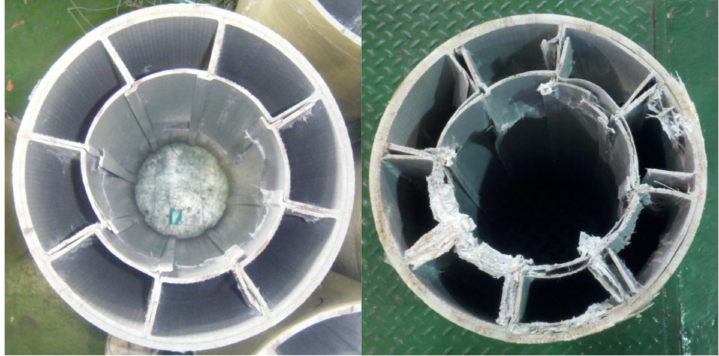
Figure 9. Fracture mode of PFRP − FFRP. Table 6. Compressive strength testing result of PFRP −